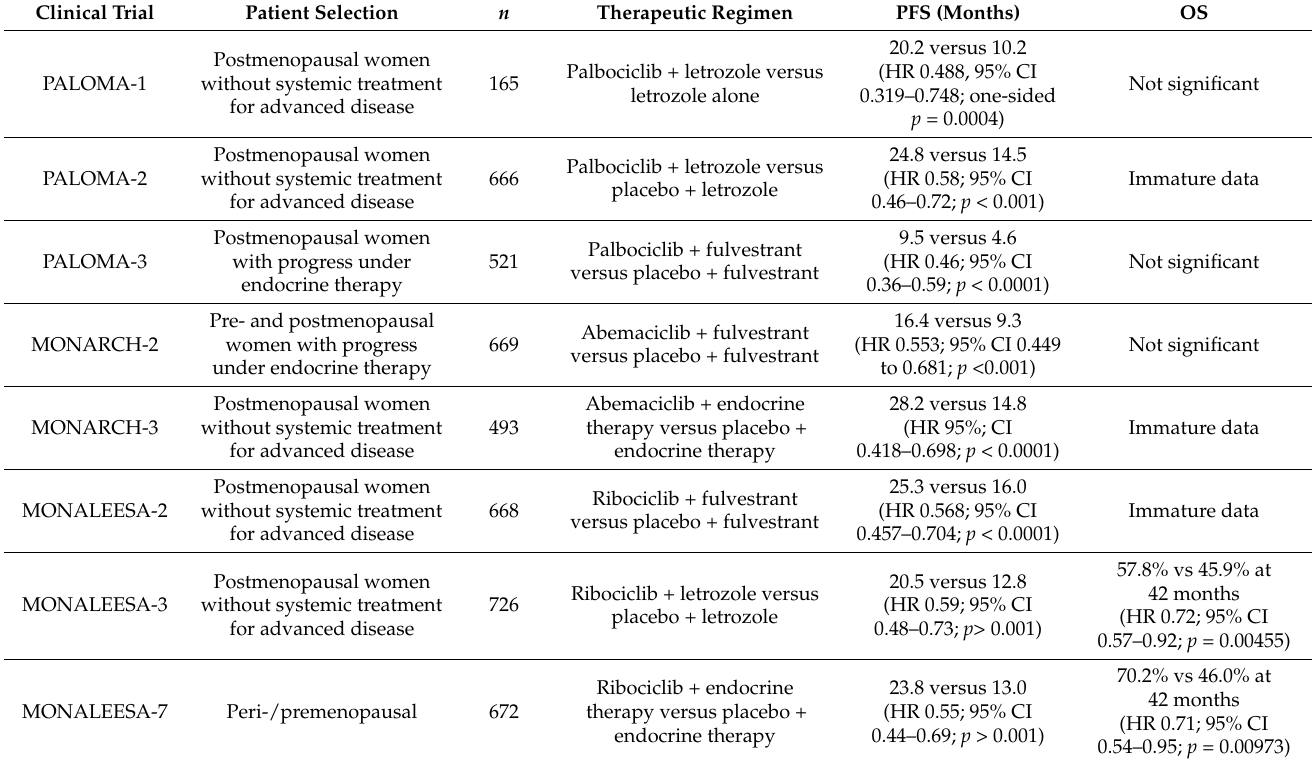
Table 1. Relevant prospective, randomized clinical trials on CDK4/6 inhibitors in patients with HR+, HER2 − metastatic breast